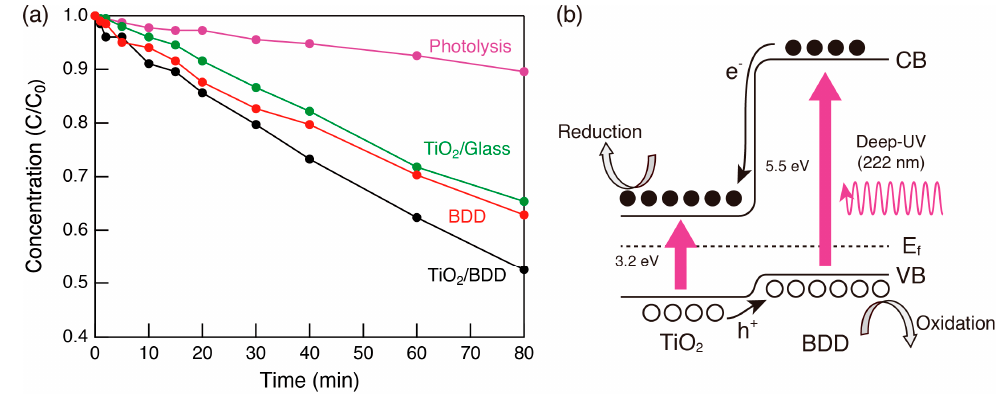
Figure 5. ( a ) Time dependence of the MB concentration, as estimated from the absorption spectra during the photocatalytic activity testing of mesoporous TiO 2 /BDD under 222 nm. For comparison, results of mesoporous TiO 2 /glass, BDD substrate, and photolysis are also included. C and C 0 are the remaining and initial concentrations of MB, respectively. ( b ) Energy diagram of the mesoporous TiO 2 /BDD and transfer mechanism of photocarriers.